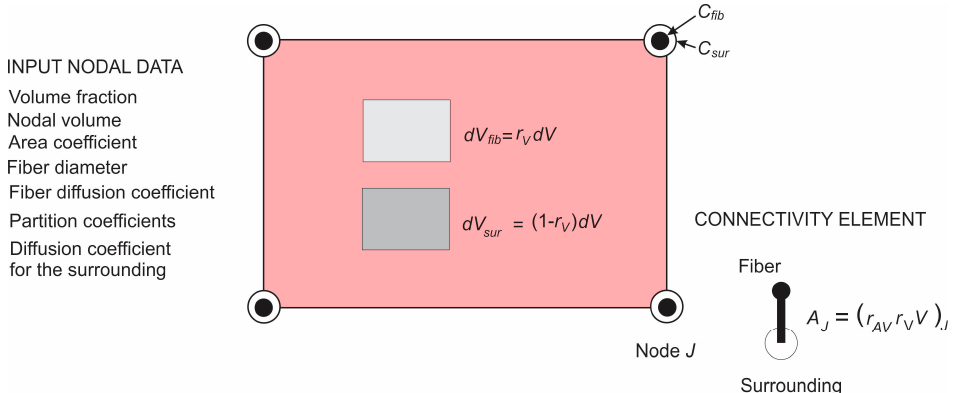
Figure 6. Composite smeared finite element (CSFE) with fiber and surrounding domain and connectivity elements at each node; a list of nodal parameters is given in the figure.